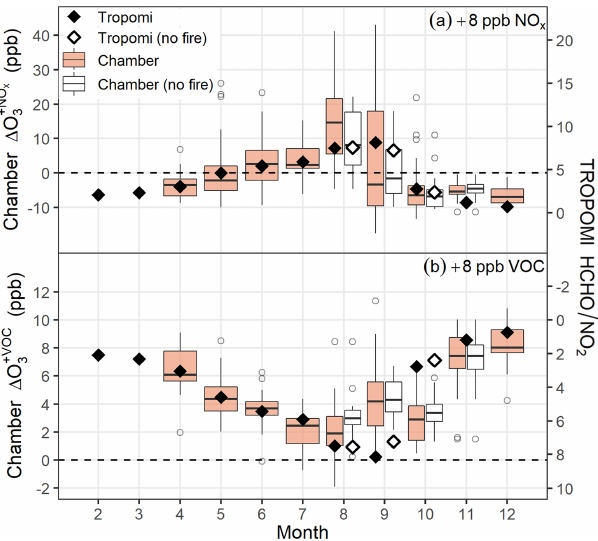
Figure 3. Monthly variation of TROPOMI HCHO / NO 2 (diamond) + NO x and (cid:49) O 3 (box) due to NO x addition ( (cid:49) O , a ) and VOC ad- 3 dition ( (cid:49) O + VOC , b ) from April to December including wildfire 3 days (shaded box) and without wildfire days (open